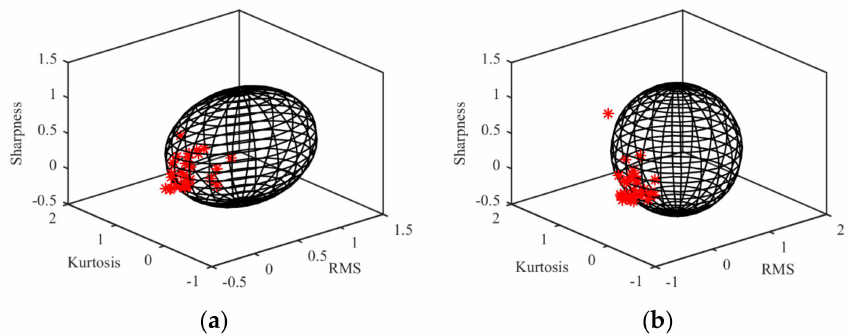
Figure 16. Flywheel #5 test noise sample point and security domain: ( a ) 3000 r / min; ( b ) 4600 r / min.